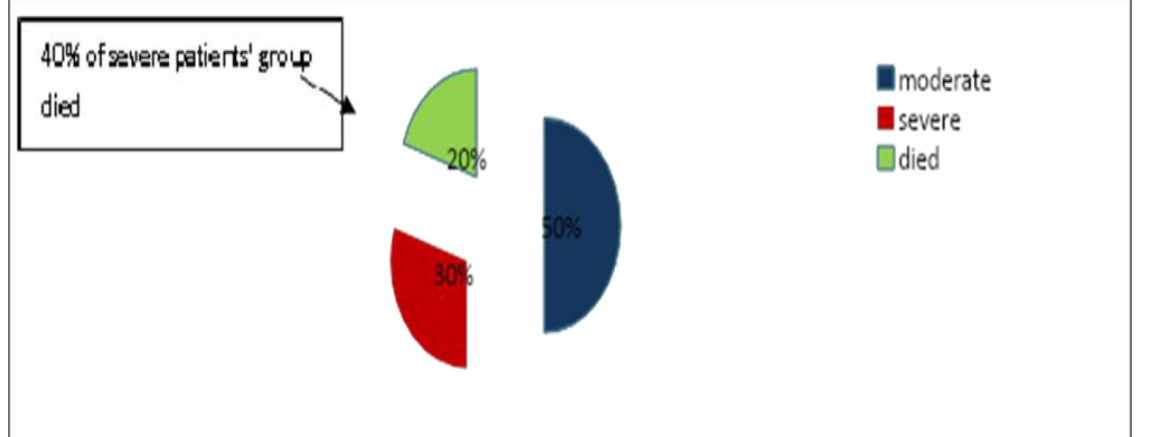
Figure 1. Outcome of COVID-19 patients according to disease